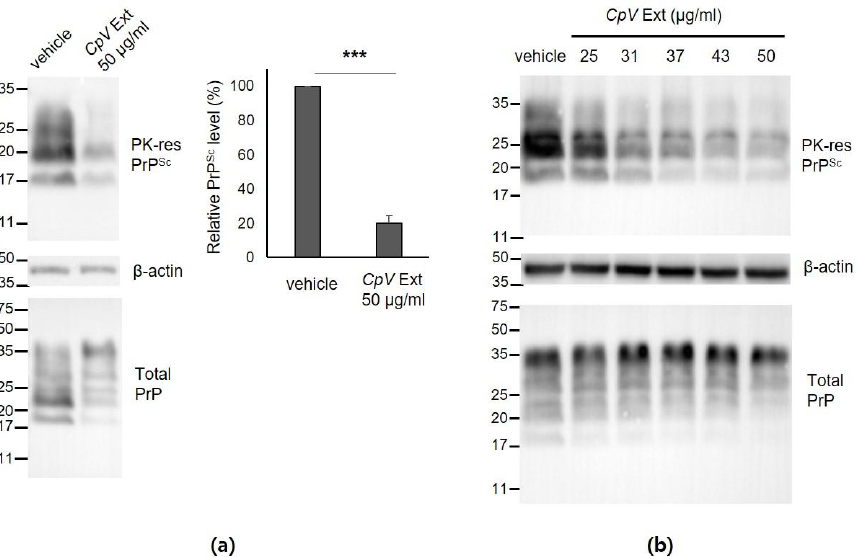
Figure 2. Anti-prion activity of CpV extract in ScN2a cells. ( a ) A representative western blot and densitometry analysis of multiple western blots (n = 4), demonstrating a reduction in PK-resistant (PK-res) PrP Sc level in ScN2a cells by CpV extract. ***, p = 0.000007. ( b ) The CpV extract concentration- responsive decrease in PK-resistant PrP Sc in ScN2a cells. β -actin was used a loading control. Total PrP was detected from ScN2a cell lysate without PK digestion.